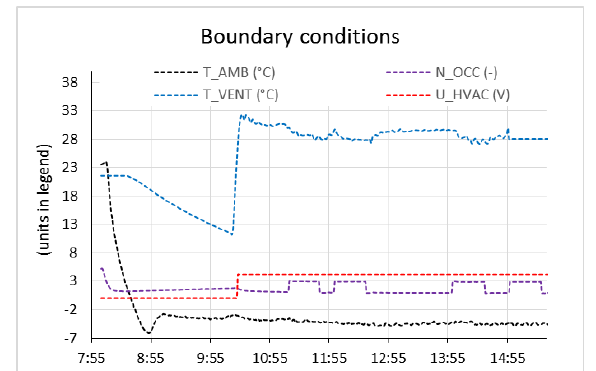
Fig. 9. Winter test for subject N.1-4. Boundary conditions.